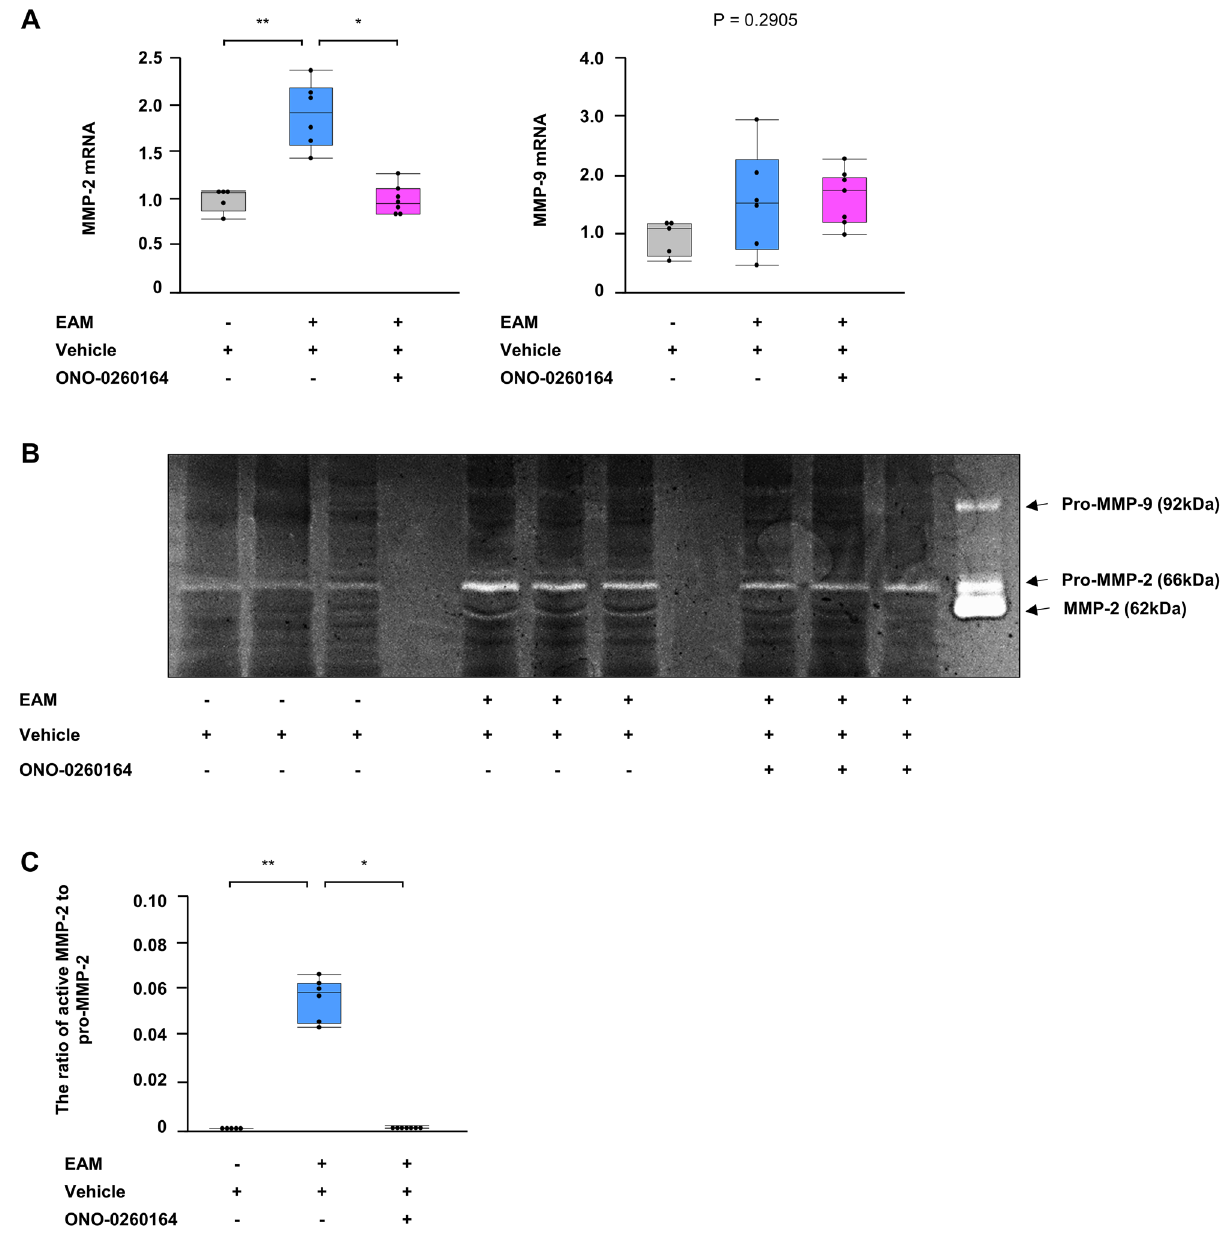
Figure 3. Expression and activation of matrix metalloproteinases (MMPs) in the heart of experimental autoimmune myocarditis (EAM) mice. ( A ) Reverse transcription-quantitative PCR, ( B ) representative gelatin zymography (cropped gel), and ( C ) densitometric analysis of MMPs including MMP-2 and MMP-9 in bulk heart tissues on day 56 obtained from non-EAM mice treated daily with vehicle (n = 5) or from EAM mice treated daily with vehicle (n = 6) or selective prostaglandin E2 receptor 4 (EP4) agonist (ONO-0260164) (n = 7) starting on day 14. The proteolytic bands of 62, 66, and 92 kDa corresponding to the active form of MMP-2, Pro-MMP-2, and Pro-MMP-9, respectively were scanned using a Photo scanner. Full-length gel of MMP-2 and MMP-9 is presented in Supplementary Fig. 4B. * P < 0.05 (vs. vehicle alone-treated EAM) or ** P < 0.05 (vs. non- EAM) calculated with 2-way ANOVA followed by the Bonferroni-Dunn post hoc testing